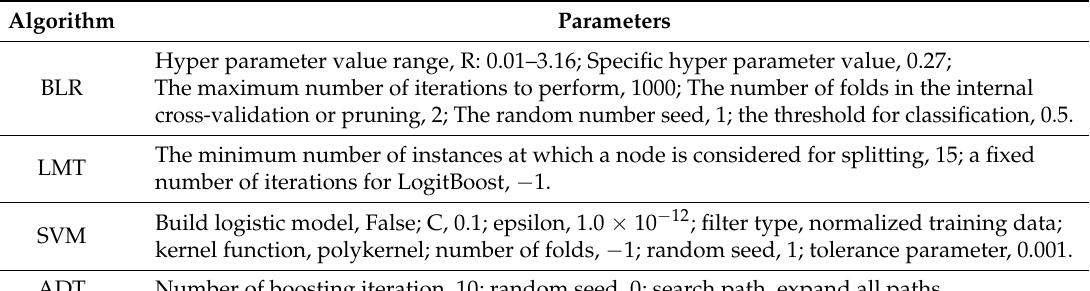
Table 3. Parameters of machine learning algorithms applied in this